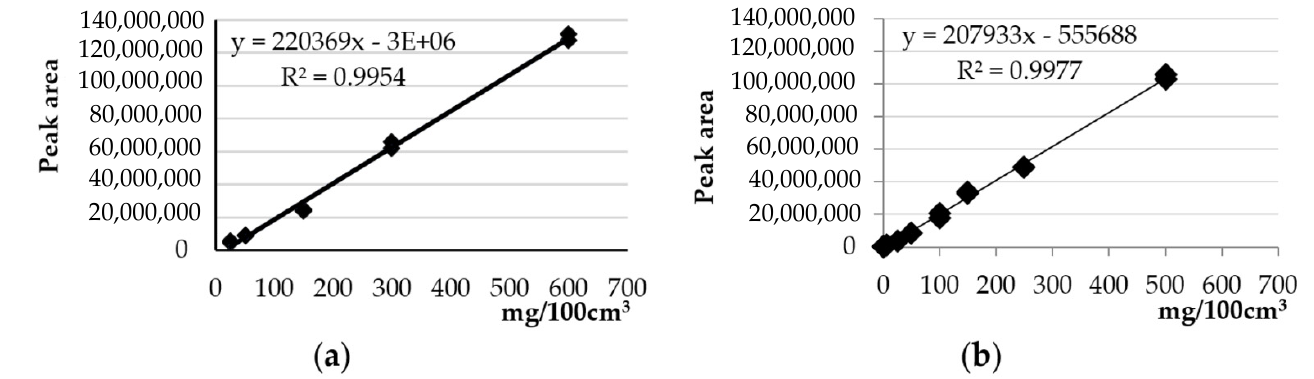
Figure 9. Standard curves of epigallocatechin gallate in ( a ) methanol and ( b ) in water. In order to prepare the mobile phase, acetic acid p .a. was mixed with distilled water to obtain a 3% solution. This solution was then filtered using a Supelco 58,061 Mobile Phase Filtration Kit with 0.45 µ m pore nylon filters (Membranes Nylon 66 0.45 um PK/50, Supelco, Bellefonte, PA, USA). A Laboport N810 FT.18 vacuum pump (KNF Neuberger)